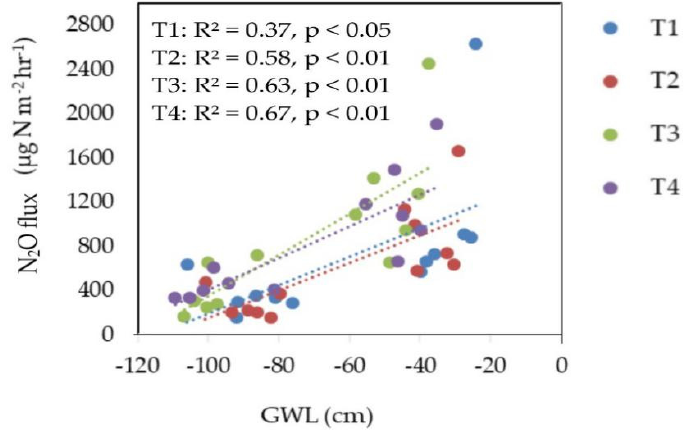
Figure 5. Relationship between GWL and N 2 O flux for each treatment in 2010.